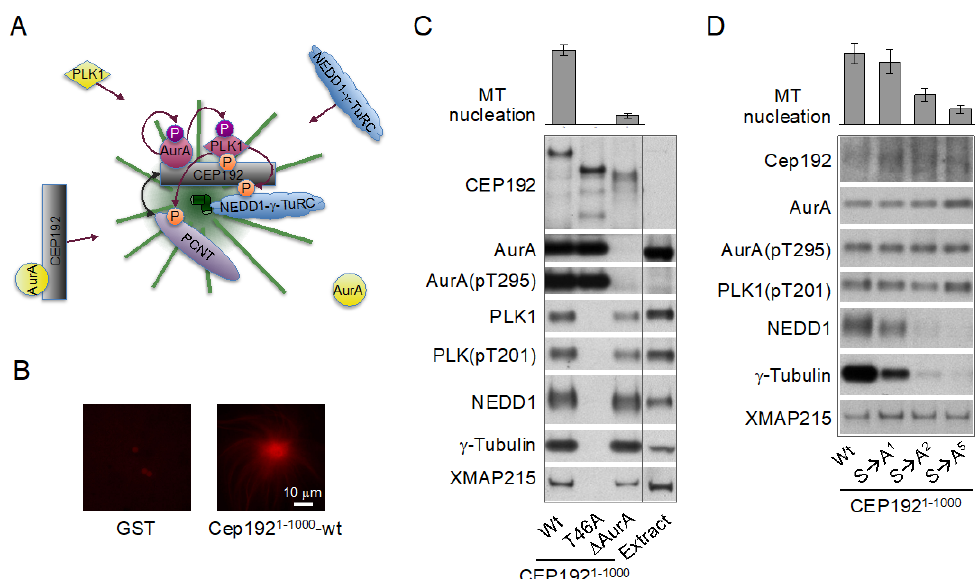
Figure 6. The centrosomal protein of 192 kDa (CEP192) organizes Aurora A (AurA) and Polo-like kinase 1 (PLK1) in a kinase cascade that drives microtubule (MT)-organizing center (MTOC) formation. ( A ) Schematic of the cascade. ( B ) Artificial centrosomes formed by magnetic beads coated with a recombinant N-terminal fragment of CEP192 (amino acids 1–1000) wild type (wt) (CEP192 1-1000 -wt), which binds AurA, PLK1, NEDD1- γ -TuRC (developmentally down-regulated protein 1- γ -tubulin ring complex), and Xenopus MT-associated protein of 215 kDa (XMAP215) [also known as cytoskeleton-associated protein 5 (CKAP5)] in a metaphase-arrested Xenopus egg extract. Beads coated with glutathione S-transferase (GST) are shown as a control. The extract was supplemented with rhodamine-labeled α / β -tubulin to visualize MTs. ( C ) Western blots of proteins retrieved from a metaphase-arrested Xenopus egg extract with beads coated with CEP192 1-1000 -wt or with its mutant counterparts lacking the binding sites for PLK1 (T46A) or AurA ( δ AurA). ( D ) Western blots of proteins retrieved from a metaphase-arrested Xenopus egg extract with beads coated with CEP192 1-1000 -wt or with its mutant counterparts lacking one (S → A 1 ), two (S → A 2 ), or five (S → A 5 ) NEDD1- γ -TuRC-binding serines. AurA(pT295) and PLK1(pT201): AurA and PLK1 isoforms phosphorylated at the conserved threonine residue in the T loop. The graphs in ( C) and ( D ) show a relative e ffi ciency of MT nucleation (proportion of bead-induced MT asters). Extracts analyzed by Western blotting in ( C , D ) were supplemented with nocodazole to prevent MT assembly. All images are adapted from